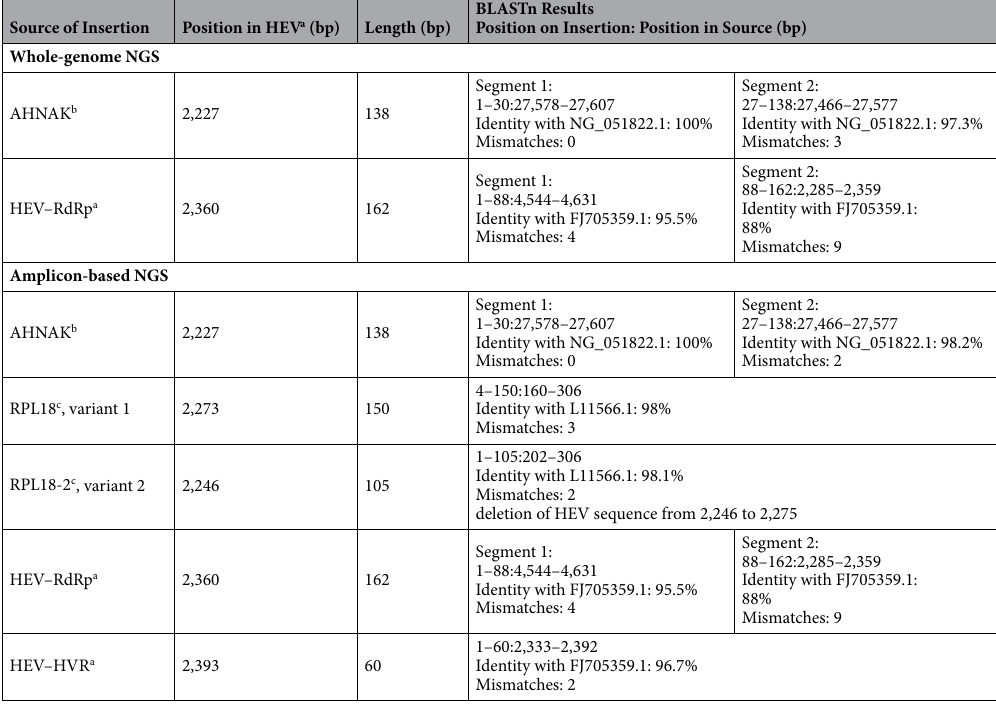
Table 3. BLASTn results of the insertions. a Using wbGER27 as reference (accession No: FJ705359.1); b homo sapiens AHNAK nucleoprotein (accession No.: NG_051822.1); c homo sapiens ribosomal protein L18 (accession No.: L11566.1).